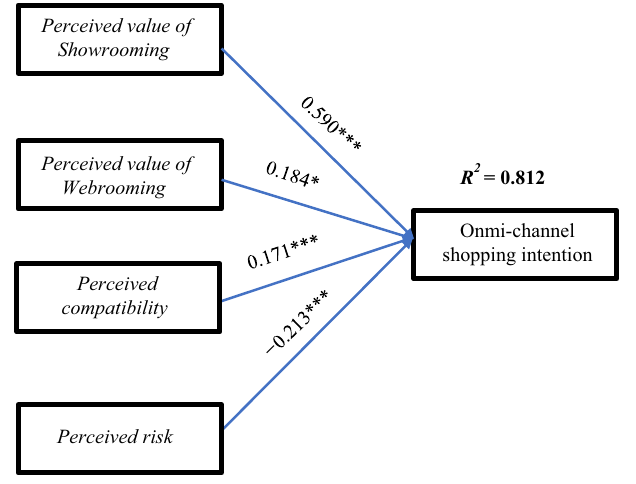
Figure 2. Final PLS-SEM